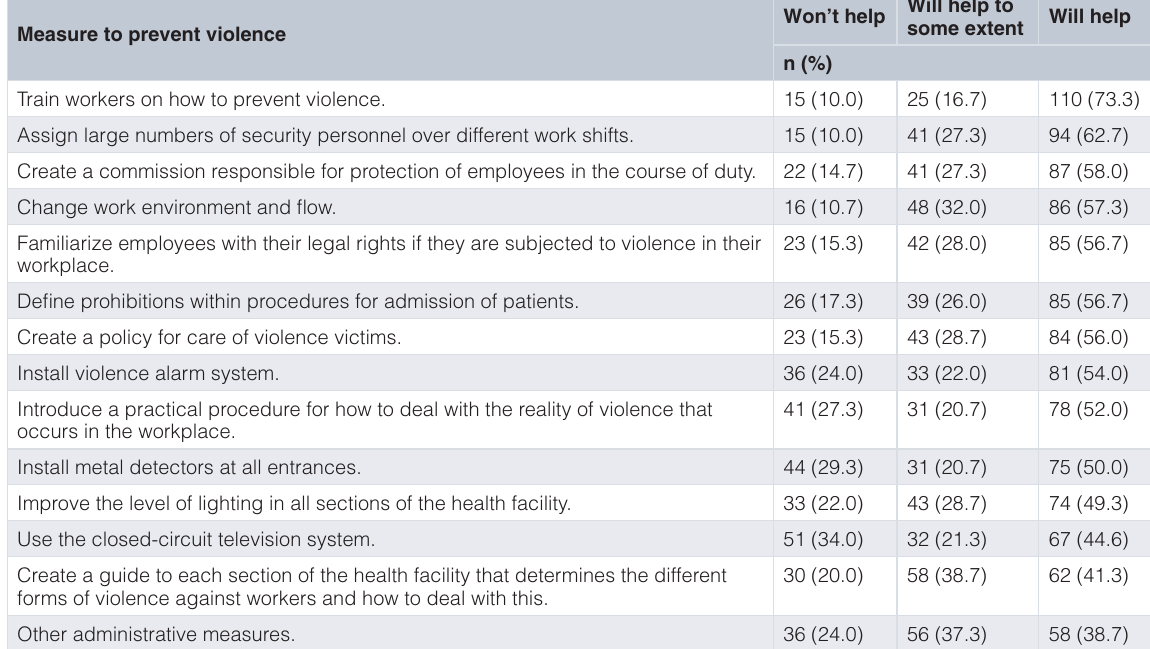
Will help to Won’t help Will help some extent n (%)